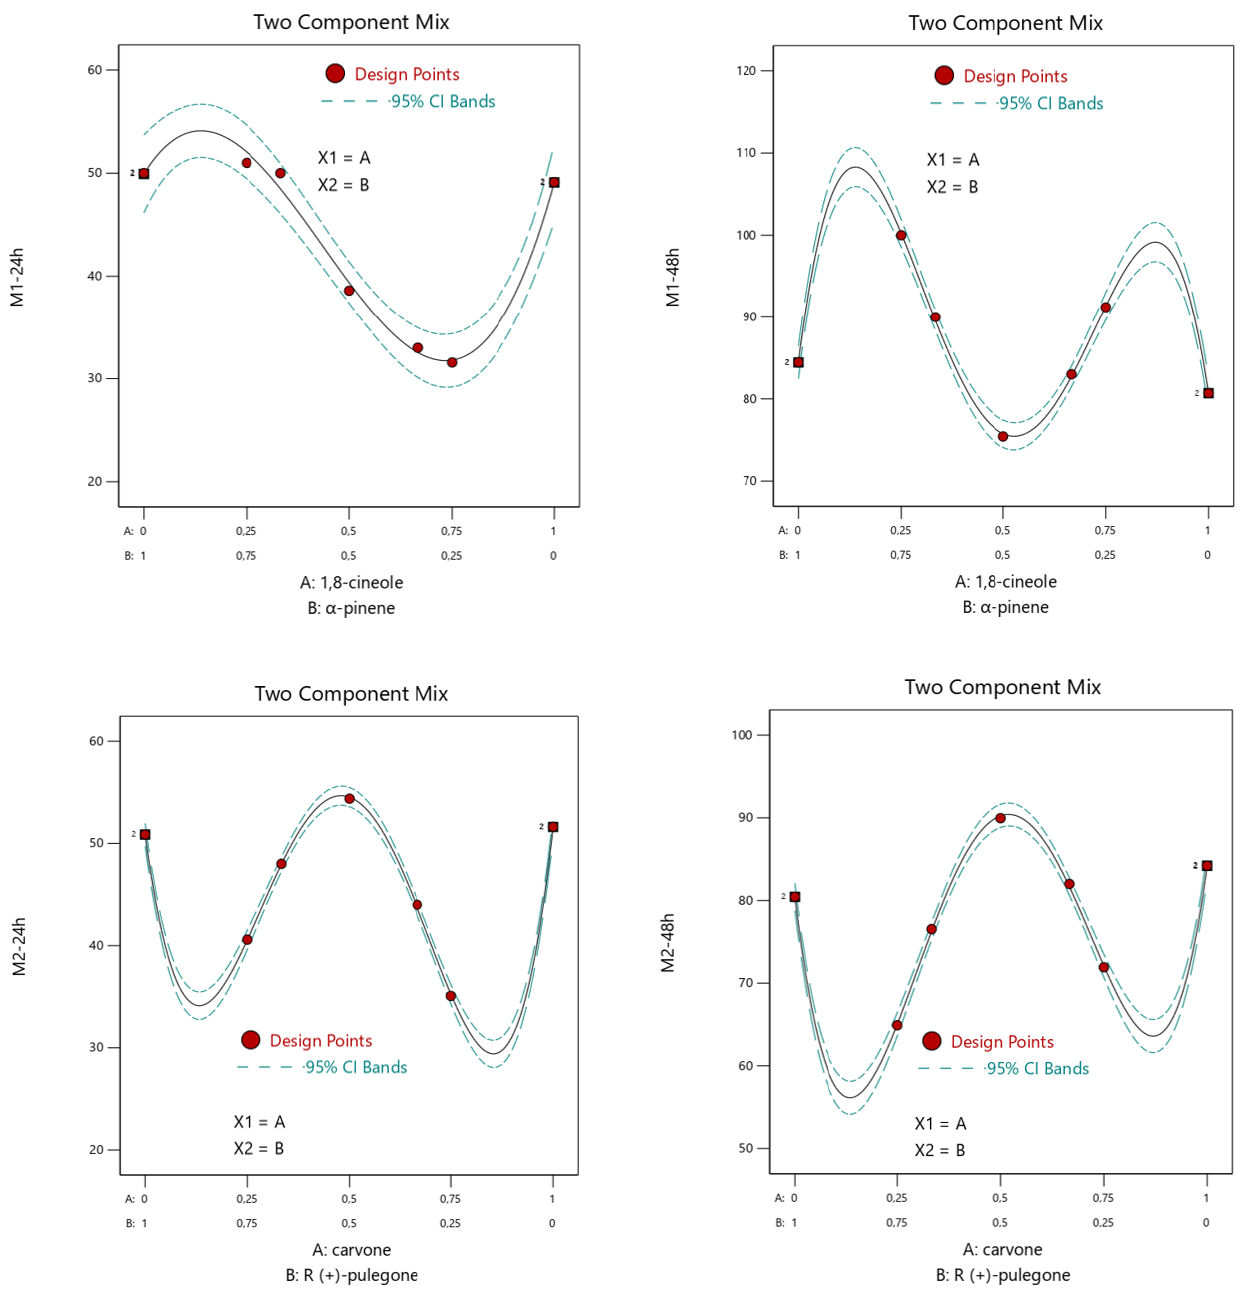
Figure 3. Binary combination graph showing the area of maximization of the response studied as a function of the compound proportion. M1, 1,8-cineole + α -pinene; M2, carvone + R (+)-pulegone.